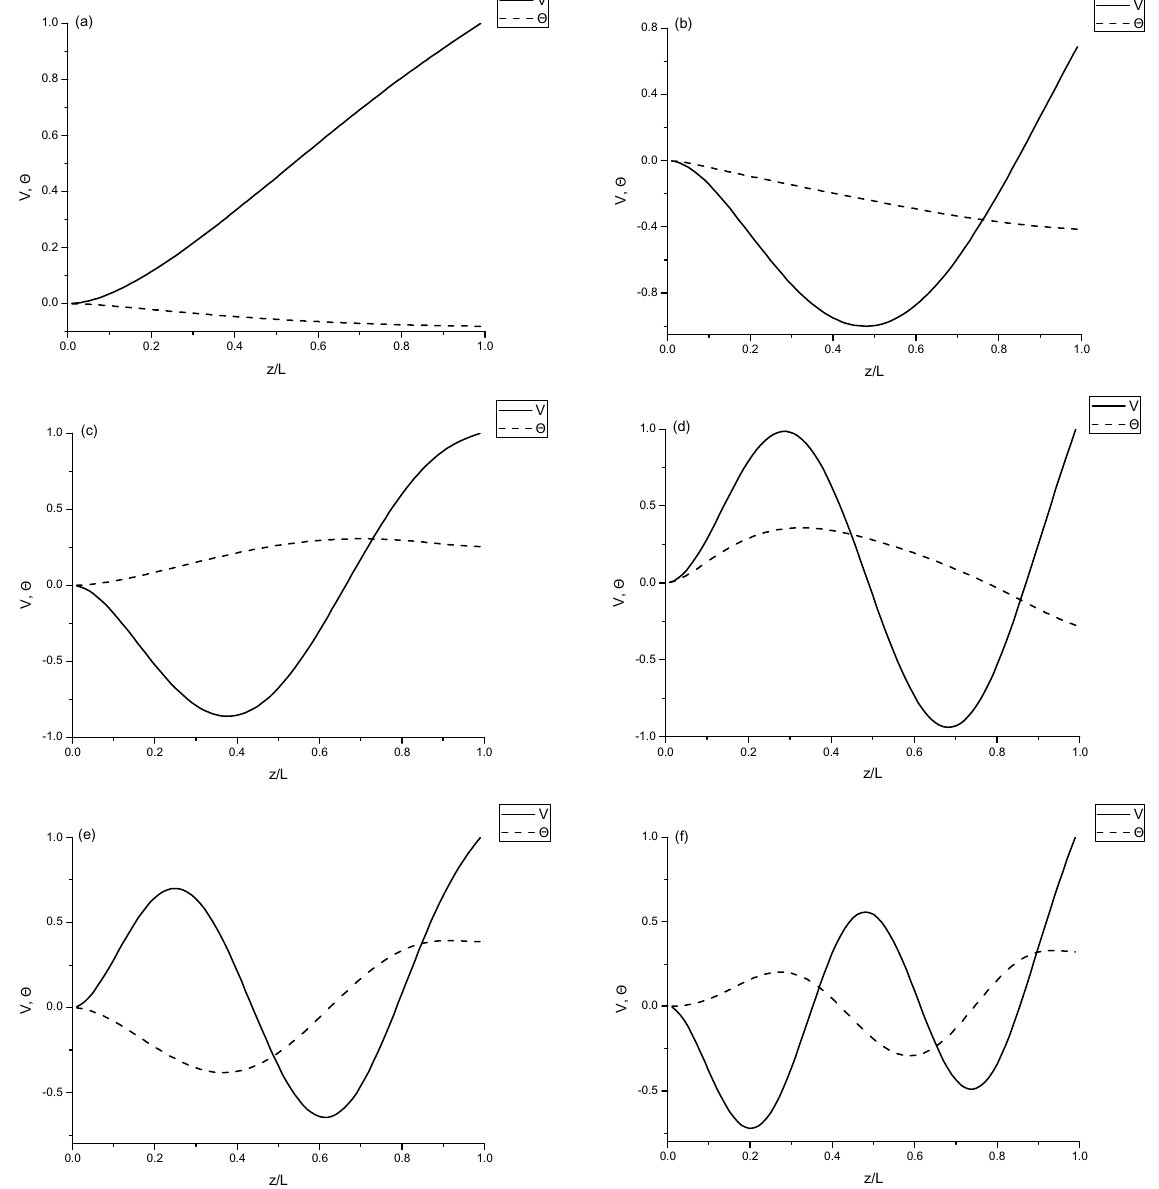
Fig. 6. First six normal mode shapes of Clamped-Free rectangular cross-section beam with aspect ratio b / a = 1000 : (a) mode 1; (b) mode 2; (c) mode 3; (d) mode 4; (e) mode 5; (f) mode 6.